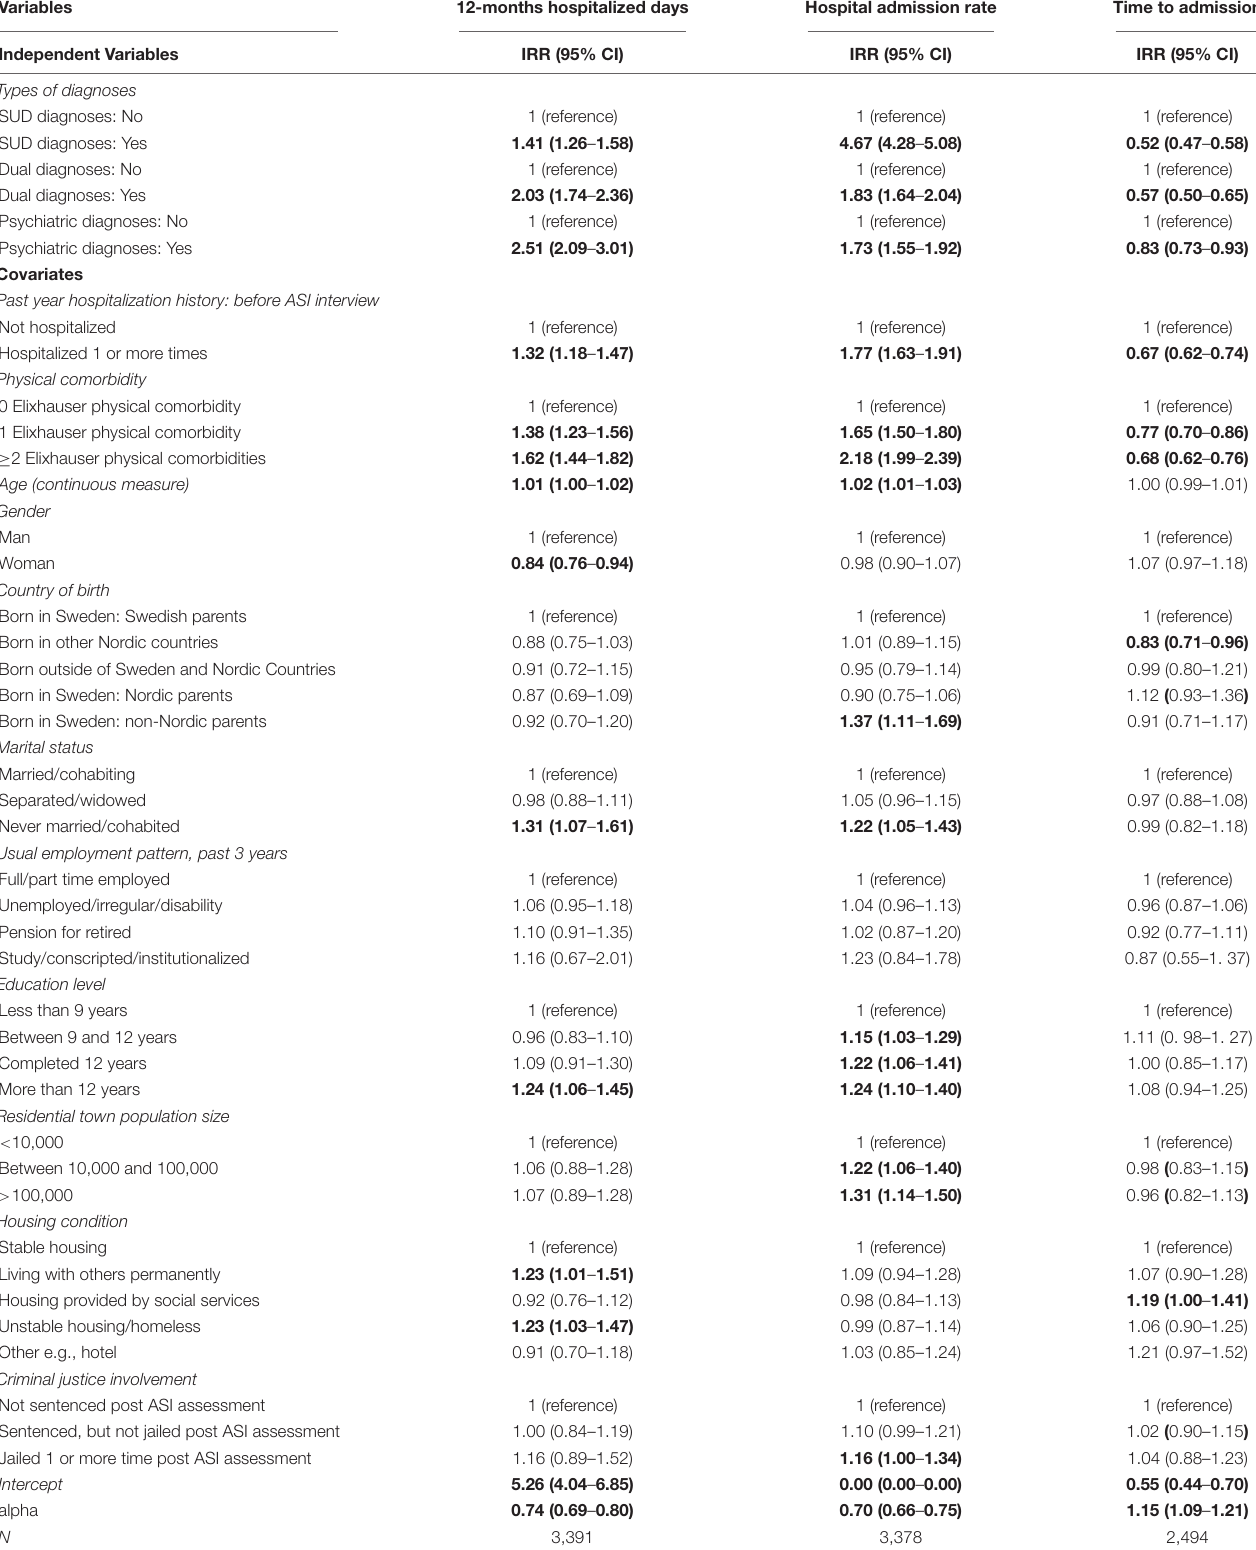
TABLE 2 | Incidence rate ratios (IRR) for substance use disorders (SUD), dual and psychiatric diagnoses associated with 12-month hospitalized days, hospital admission rate and time to hospital